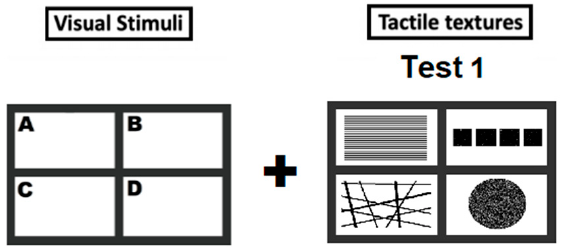
Figure 4. Visual stimuli and tactile texture for test 1. Partially adapted from [20].